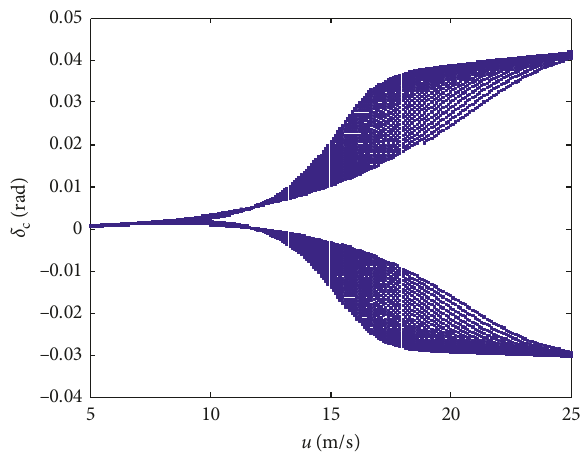
Figure 3: Relationship between compliance steering angle δ the velocity u